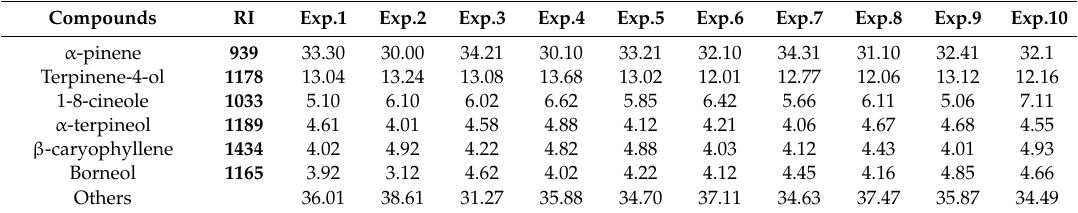
Table 5. Areas of compounds found in the oils obtained by SFE from